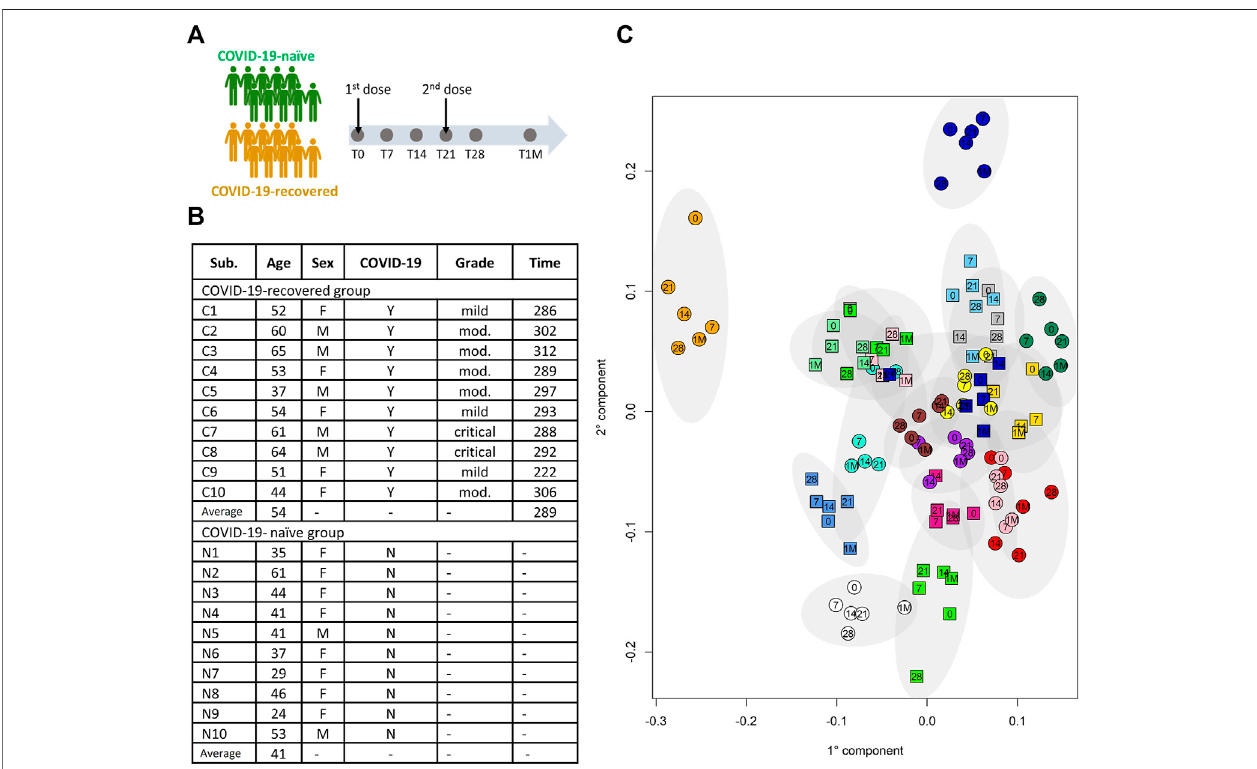
FIGURE 1 | (A) Schematic representation of the study design. (B) Table summarizing the main demographic characteristics of the subjects included in the study; theCOVID-19-recoveredand -naïve subjectsareindicated withCand N,respectively;forthe COVID-19-recoveredgroupthecolumn “ Grade ” referstothegradeofthe disease severity, i.e. mild, moderate (mod.) or critical; the column “ Time ” refers to the time (in days) from COVID-19 diagnosis to the fi rst dose of vaccine. (C) Individual metabolic phenotype as itresults from aPCA-CA score plot (binned NOESYspectra). Each color representsa different subject; squares: COVID-19-naïve; circles: COVID-19-recovered. Numbers indicate the collection time: T0 = 0, T7 = 7, T14 = 14, T21 = 21, T28 = 28, T1M =